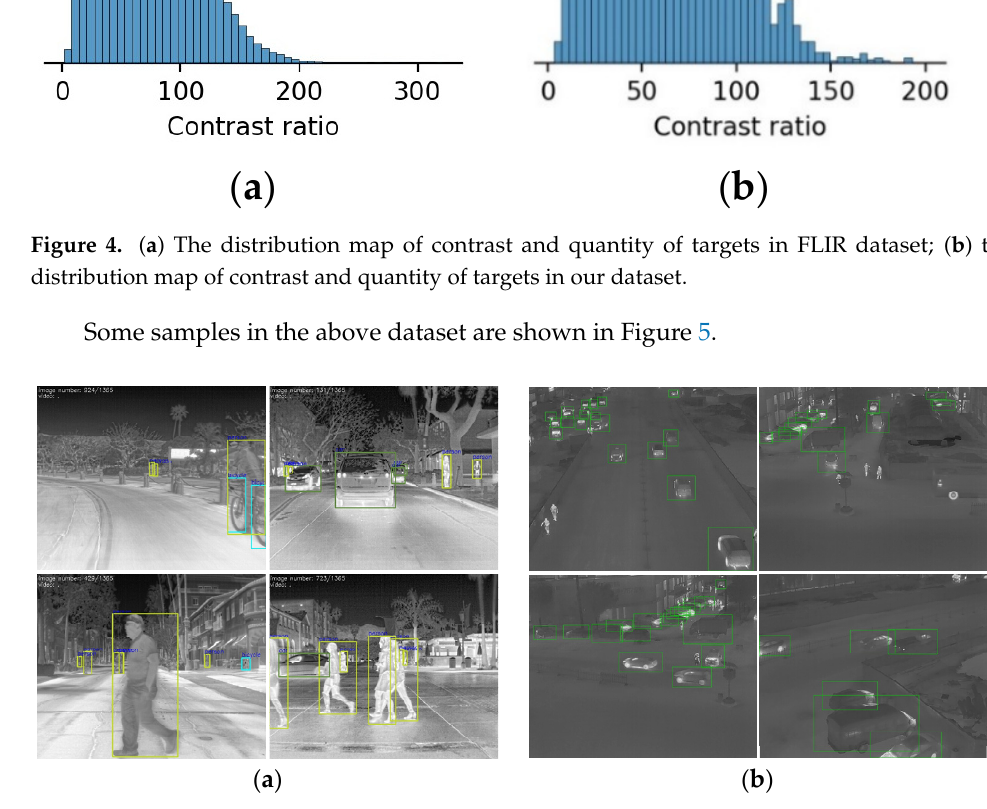
Figure 5. Display of some images in the dataset mentioned in this article. ( a ) some images of FLIR dataset; ( b ) some images of our dataset.